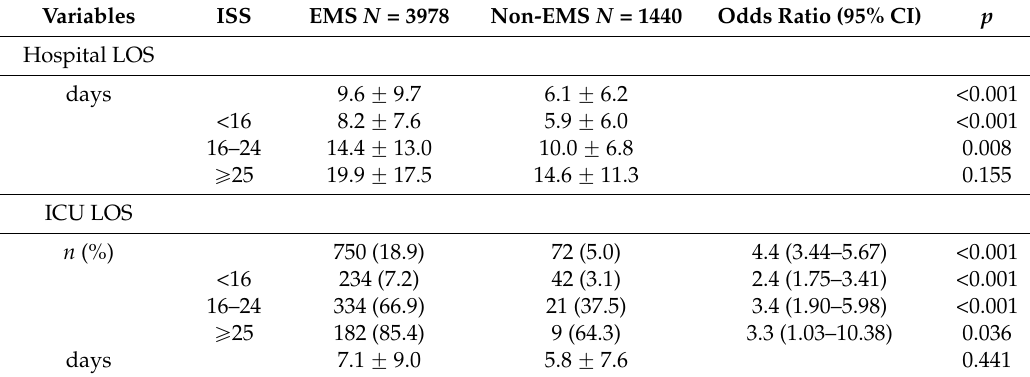
Table 5. Length of stay in the hospital and the intensive care unit (ICU) of patients transported by Emergency Medical Services (EMS) and